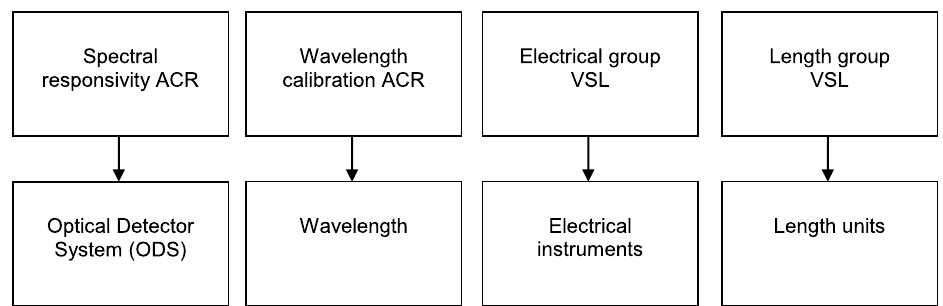
Fig. 3. Traceability chart. ACR stands for Absolute Cryogenic Radiometer.